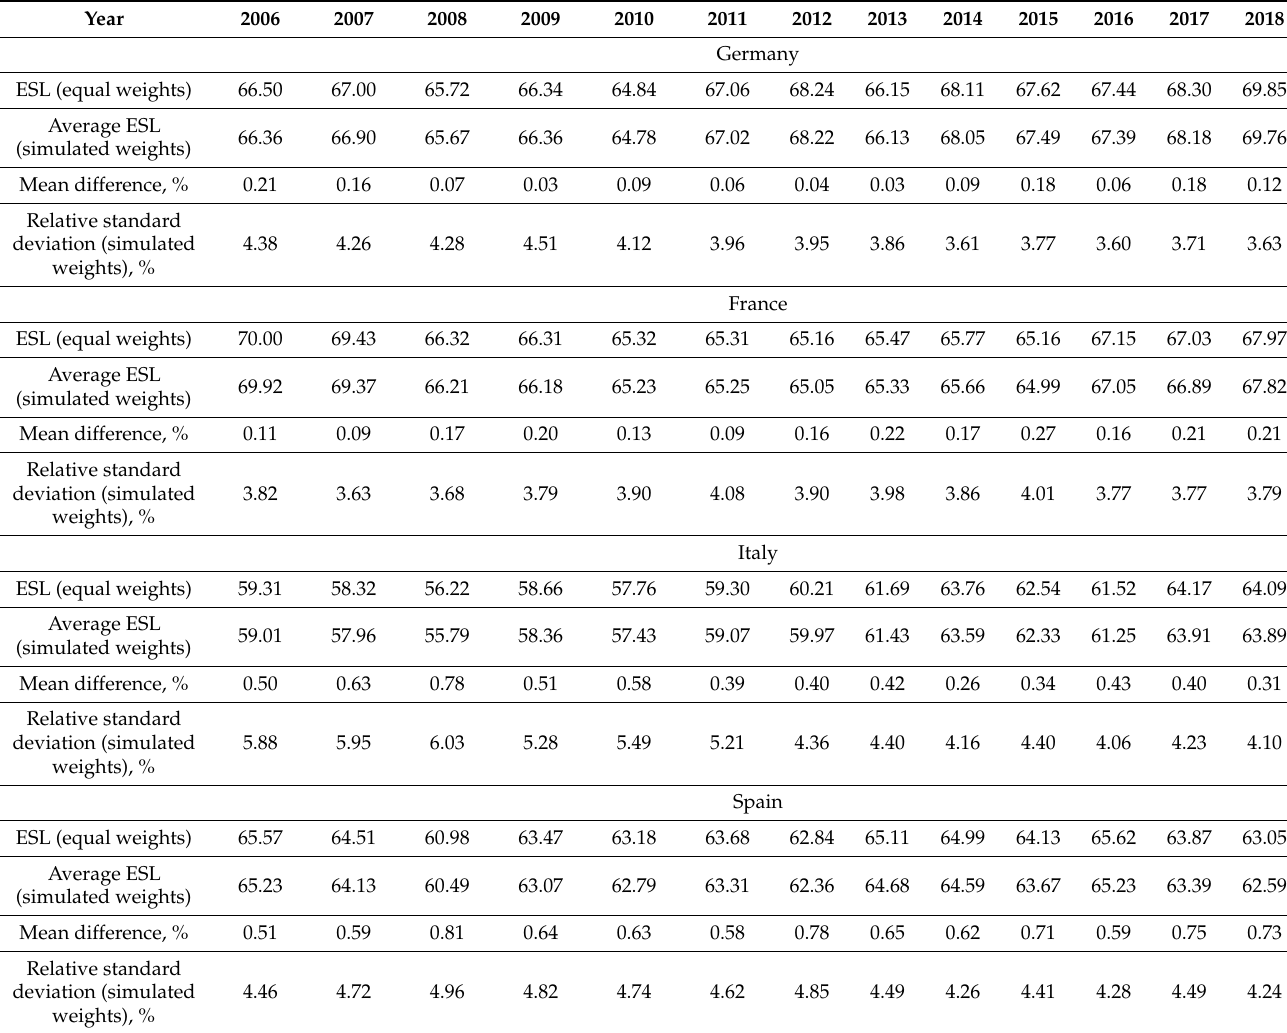
Table 7. Results of uncertainty analysis for indicator weights. Source: own